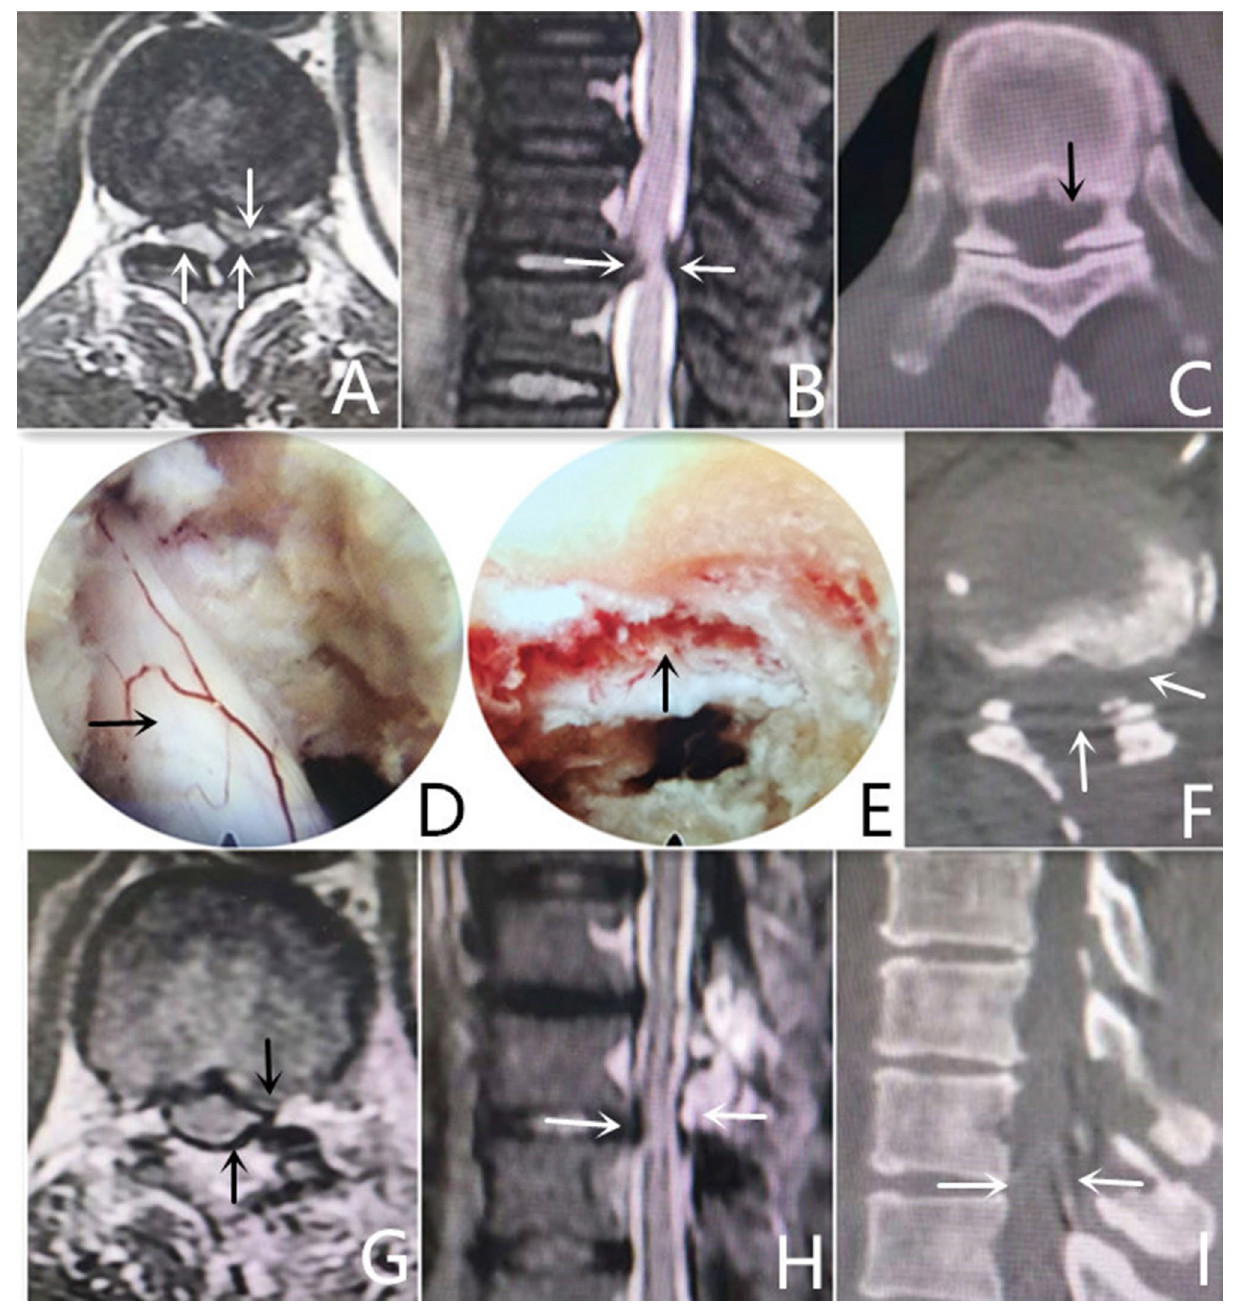
Figure 2. Typical cases. ( A – C ) Preoperative CT and MRI examinations showed T 10/11 disk herniation on the left side with ossification of the ligamentum flavum and thoracic spinal cord degeneration in the corresponding segment. ( D ) Dura mater exposure after decompression via the posterior approach. ( E ) Dura mater margin exposure under decompression via the posterolateral approach. ( F – I ) Postoperative CT and MR showed that the disc herniated, the ossified ligamentum flavum was removed, and there was no compression in the dura